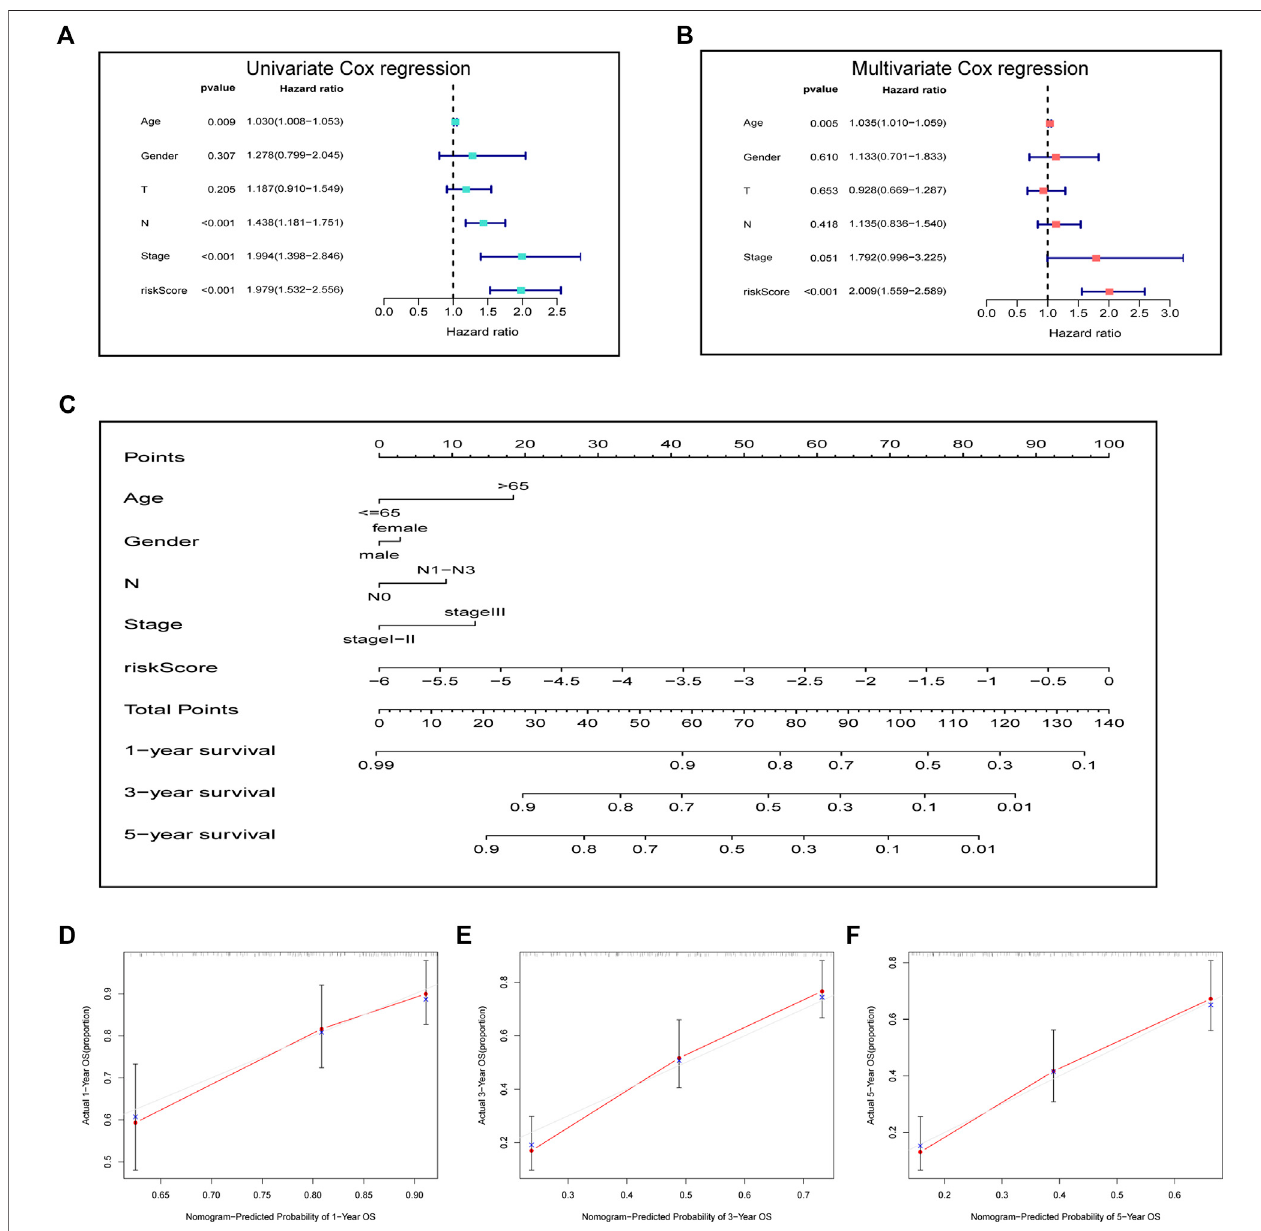
FIGURE 4 | Prognostic signature in combination with clinical parameters for predicting prognostic outcomes for ESCC cases. (A) Univariate analysis and (B) multivariate analysiscontainingthe riskscore and clinical factors. (C) Nomogram forpredicting one-,three-, and fi ve-year OS. (D – F) Calibration curves ofnomogram on consistency between predicted and observed one-, three-, and fi ve-year